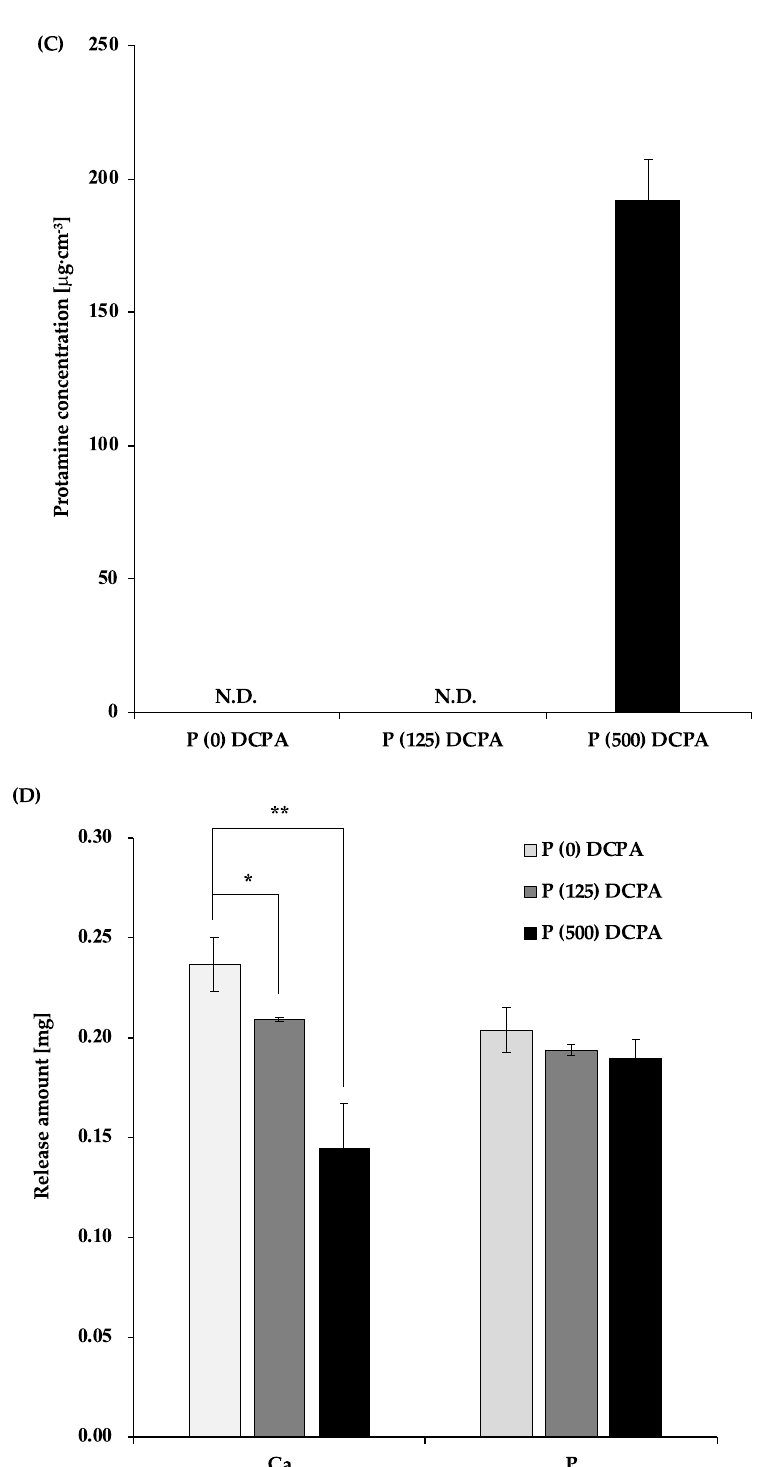
Figure 2. Analysis of the supernatants of fabricated discs. The supernatants of the discs were explored after incubation of S. mutans in culture without sucrose for 24 h. Error bars indicate the standard error of the mean ( n = 3–6). The asterisks show * p < 0.05, ** p < 0.01 by Student’s t -test. ( A ) S. mutans cells in supernatant were evaluated by colony counting on an agar plate at 48 h, post-infection. ( B ) The pH value of the supernatant was measured by a pH meter. ( C ) Protamine concentration in supernatant was quantified by Bradford assay. ( D ) Calcium and phosphate release from the discs were quantified by ICP-AES.